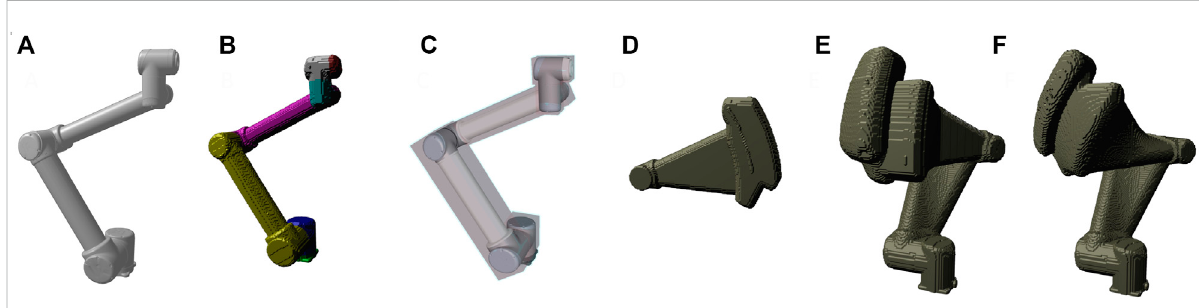
FIGURE 2 Intermediate steps of the robot safety space generation (A – F) ; Polygonal representation (A) , Voxel Representation (B) , Simpli fi cation using bounding boxes (C) , Swept volume when breaking 3rd joint (D) , Combined result of braking 1st and 3rd joint (E) , Space covered by ideal controlled stop (F)